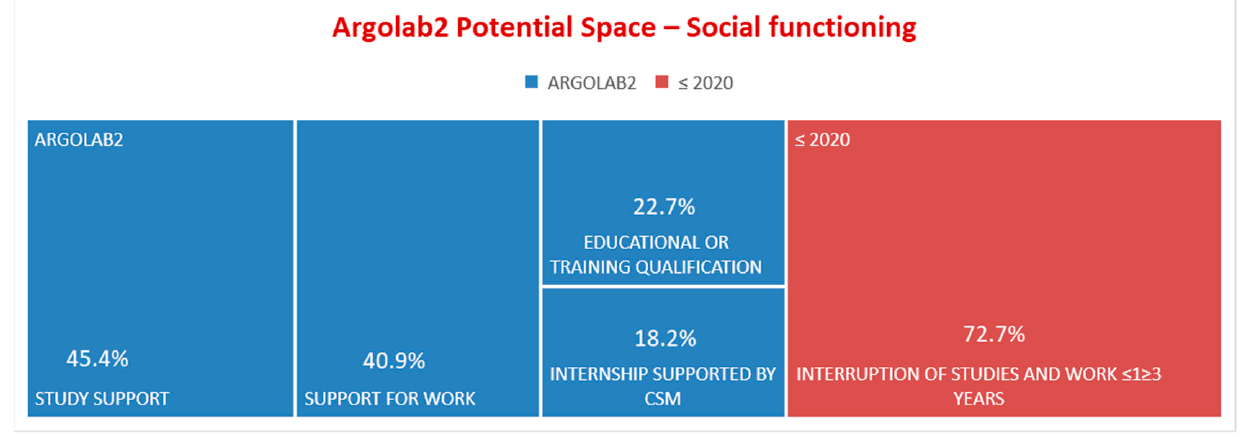
Figure 7. “ Argolab2 Potential Space ”—Social Figure 7. “Argolab2 Potential Space” —Social functioning.